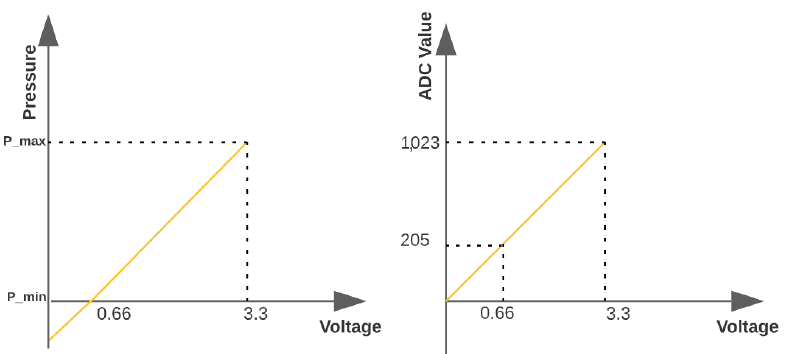
Figure 7. Relationship between measured pressure and converted value for digital form. Source: author.